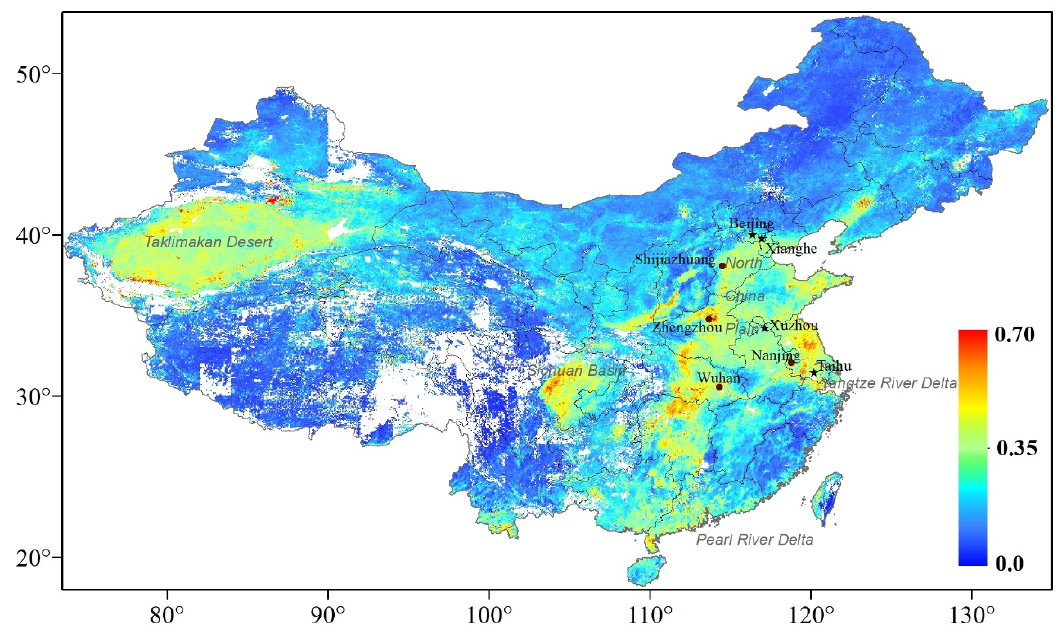
Figure 1. Multi-angle Imaging Spectroradiometer (MISR) Aerosol Optical Depth (AOD) in 2018 and location of the used AERONET (pentagram) and air quality monitoring (dot) sites.